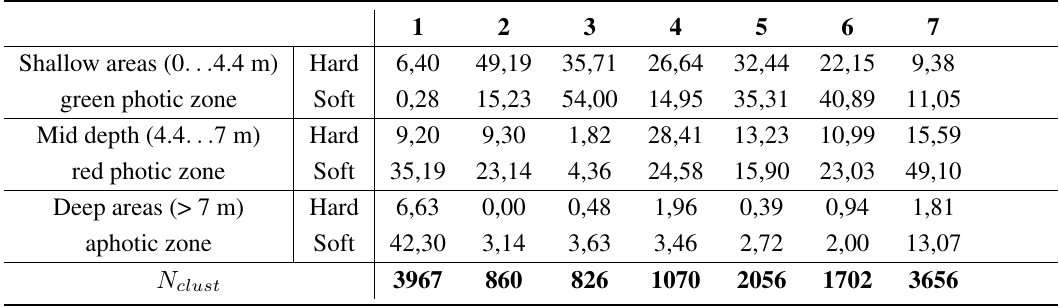
Table 4. Positive predictive value (PPV) of the obtained clusters with respect to the substrate type (hard/soft) and vegetation zone.